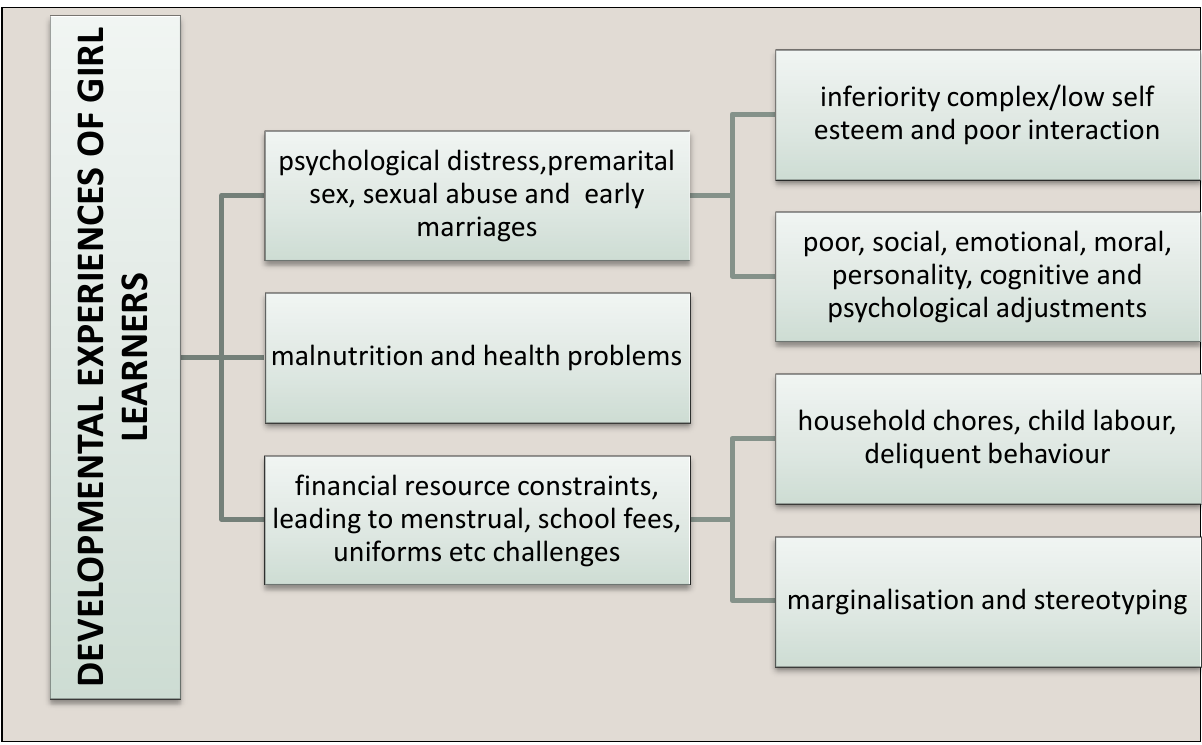
Figure 5.4: Developmental experiences encountered by girl children (Field data,